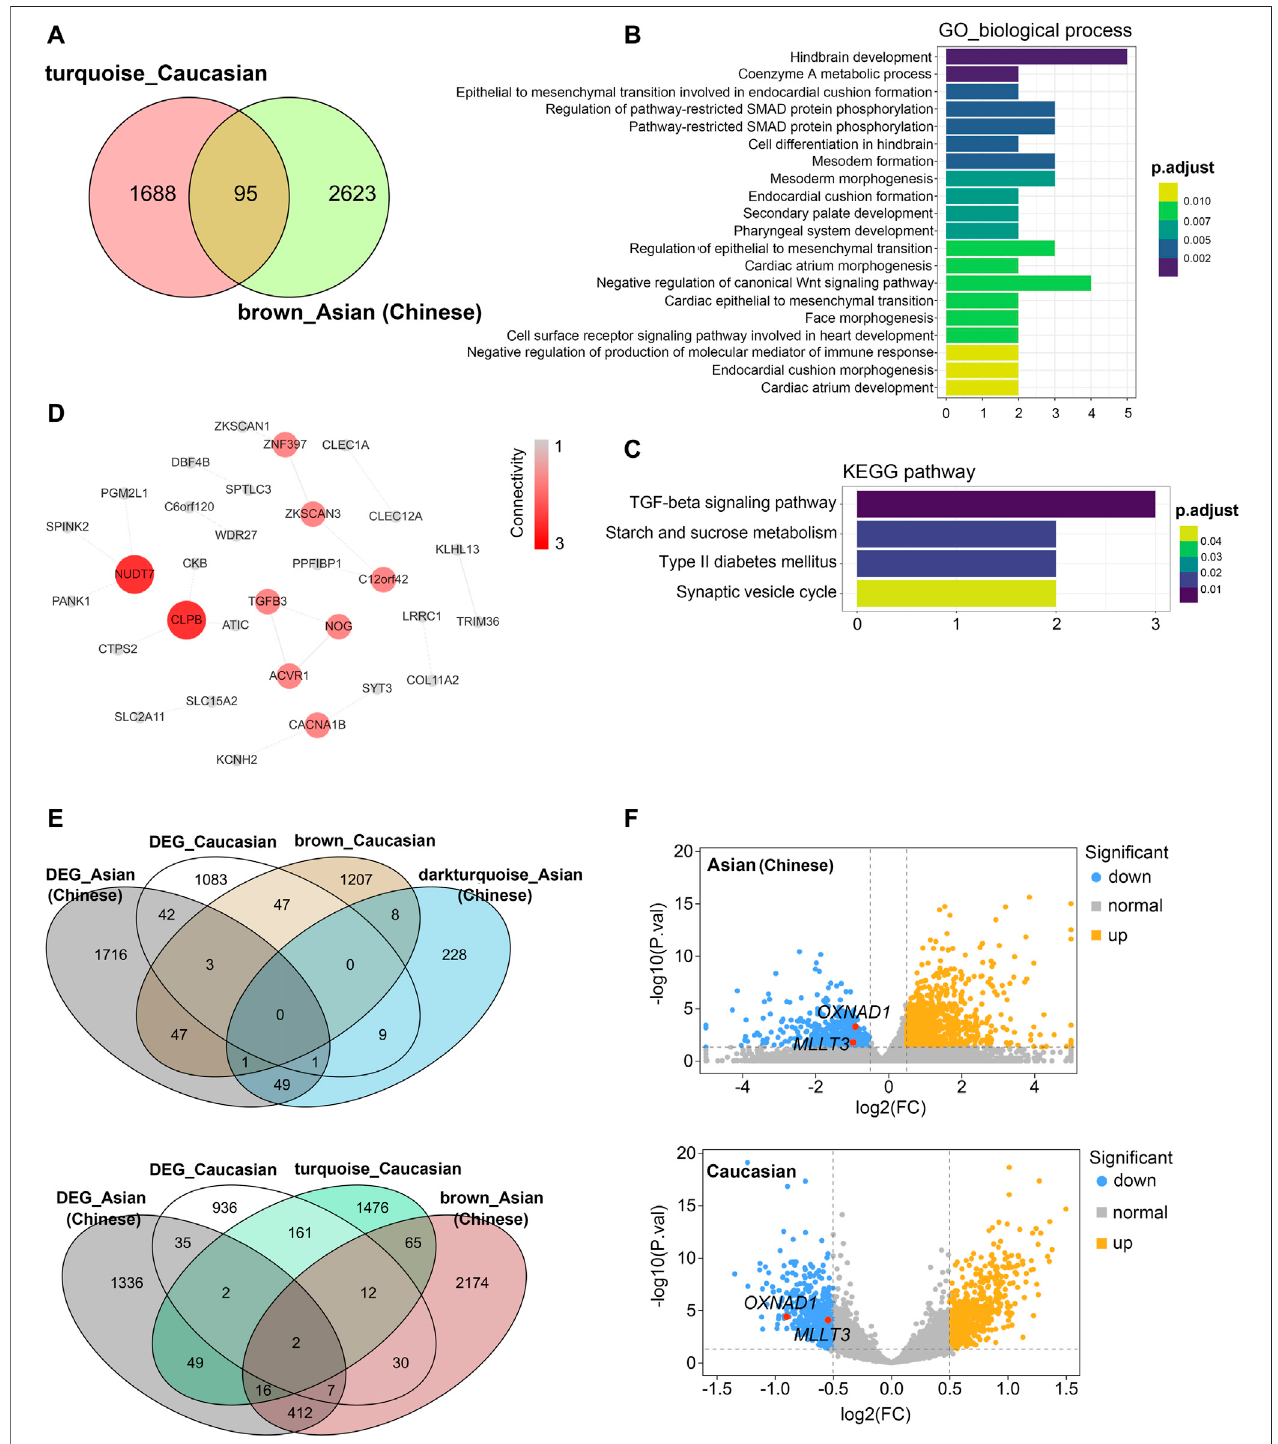
FIGURE6| Shared transcriptomic signaturesofPBMC agingbetweenCaucasian and Asian(Chinese). Thebrown module from Asian(Chinese)and theturquoise module from Caucasian and its differentially expressed genes (DEGs) were compared and listed. (A) The Venn diagram of genes among turquoise module from Caucasian and brown module from Asian (Chinese). Despite thousands of race-speci fi c gene associated with aging corresponding to 2,623 and 1,688 genes in Asian (Chinese) and Caucasian, 95 genes in Asian (Chinese) and Caucasian signi fi cantly overlapped. (B,C) GO and KEGG enrichment analyses for the 95 common shared genes. (D) Hub genes detection for 95 genes by using the STRING database, and visualized by the cytoscape. (E) The Venn diagram of differentially expressed genes (DEGs) with the age-related modules in White and Caucasian revealed two aging-speci fi c gene markers. (F) The two overlapping genes (OXNAD1 and MLLT3) were both downregulated, as shown in the volcano diagram for the DEG genes in Asian and Caucasian dataset.